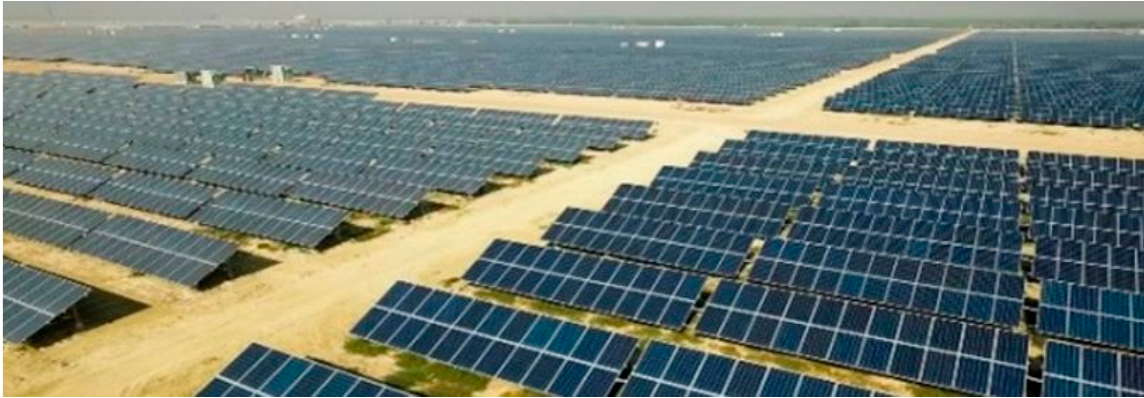
Figure 13. Typical horizontal axis wind turbine (HAWT) [25]. With respect to efficiency, according to Ref. [25], for commercially available wind turbines with around 5 kW for small residential turbines and 5 MW for large-scale utilities, the wind turbine efficiencies are 20% and 40%, respectively, measured by the percentage of wind kinetic energy into electrical energy. Note that these efficiencies are lower than 59.3%, the so-called Betz’s limit. Moreover, with respect to the amount of energy typically produced for various applications, according to Refs. [3,6], residential-scale onsite energy use is typically less than 10 kW, small commercial-scale onsite energy use is between 10